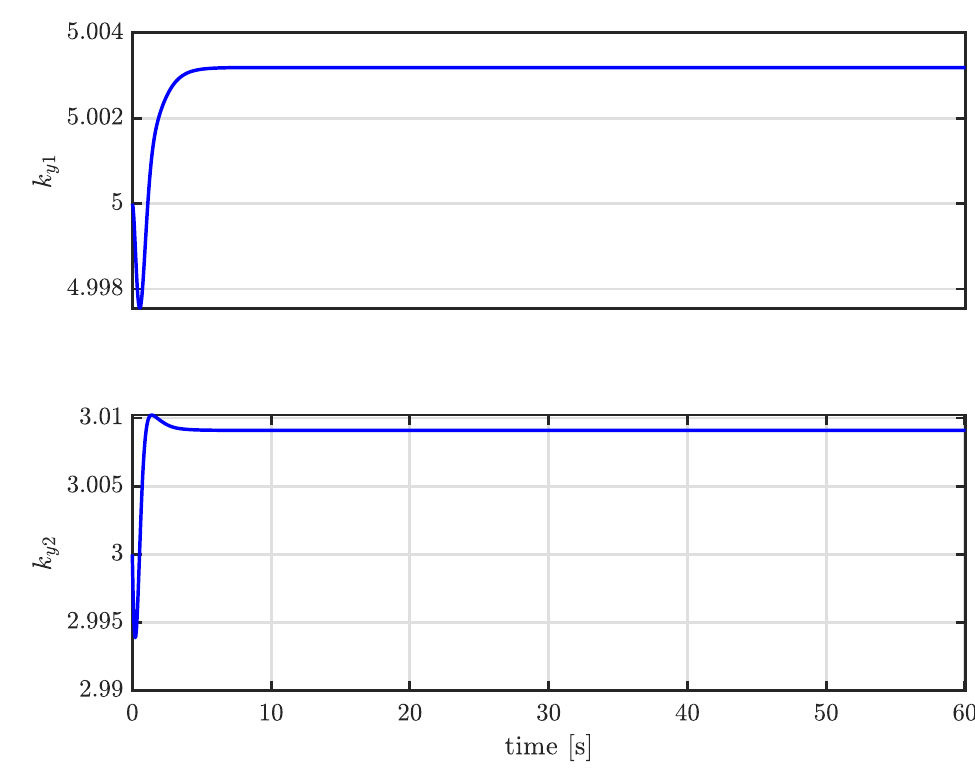
Figure 4. Control gains for yaw control (Case